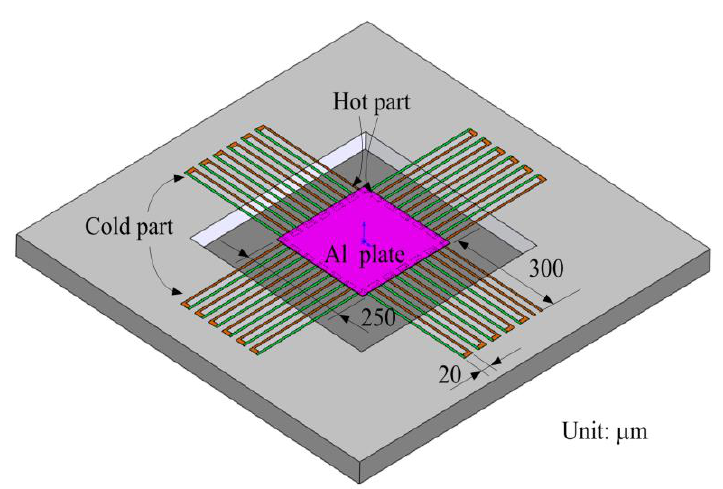
Figure 1. Schematic of the thermoelectric micro